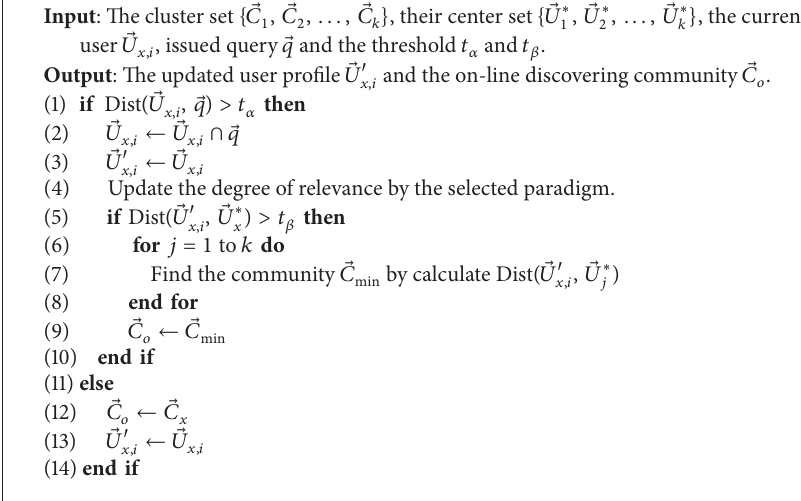
Algorithm 1: Algorithm of on-line community discovery.